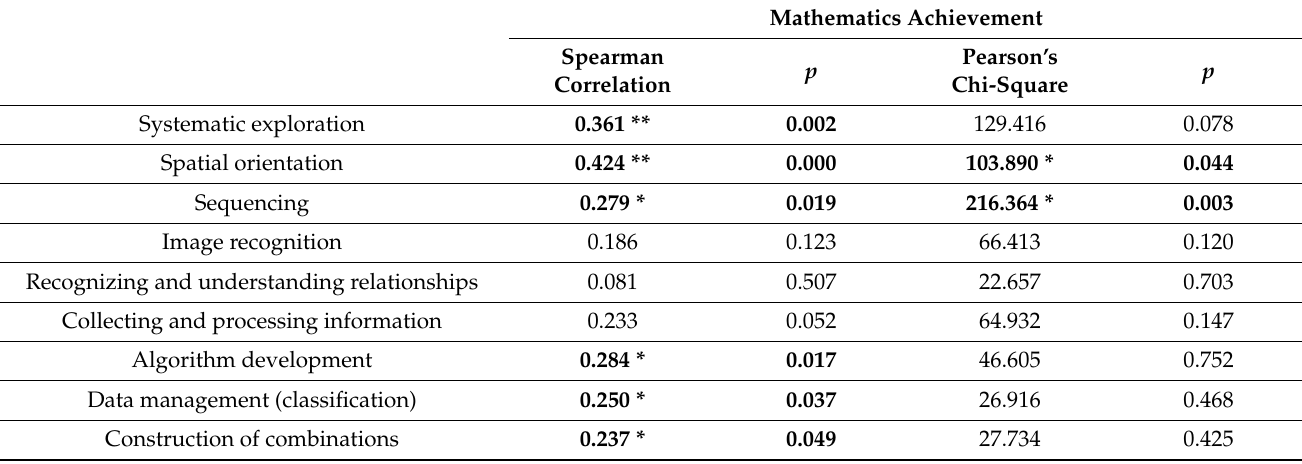
Table 4. Spearman’s correlation between cognitive functions and mathematical achievement.